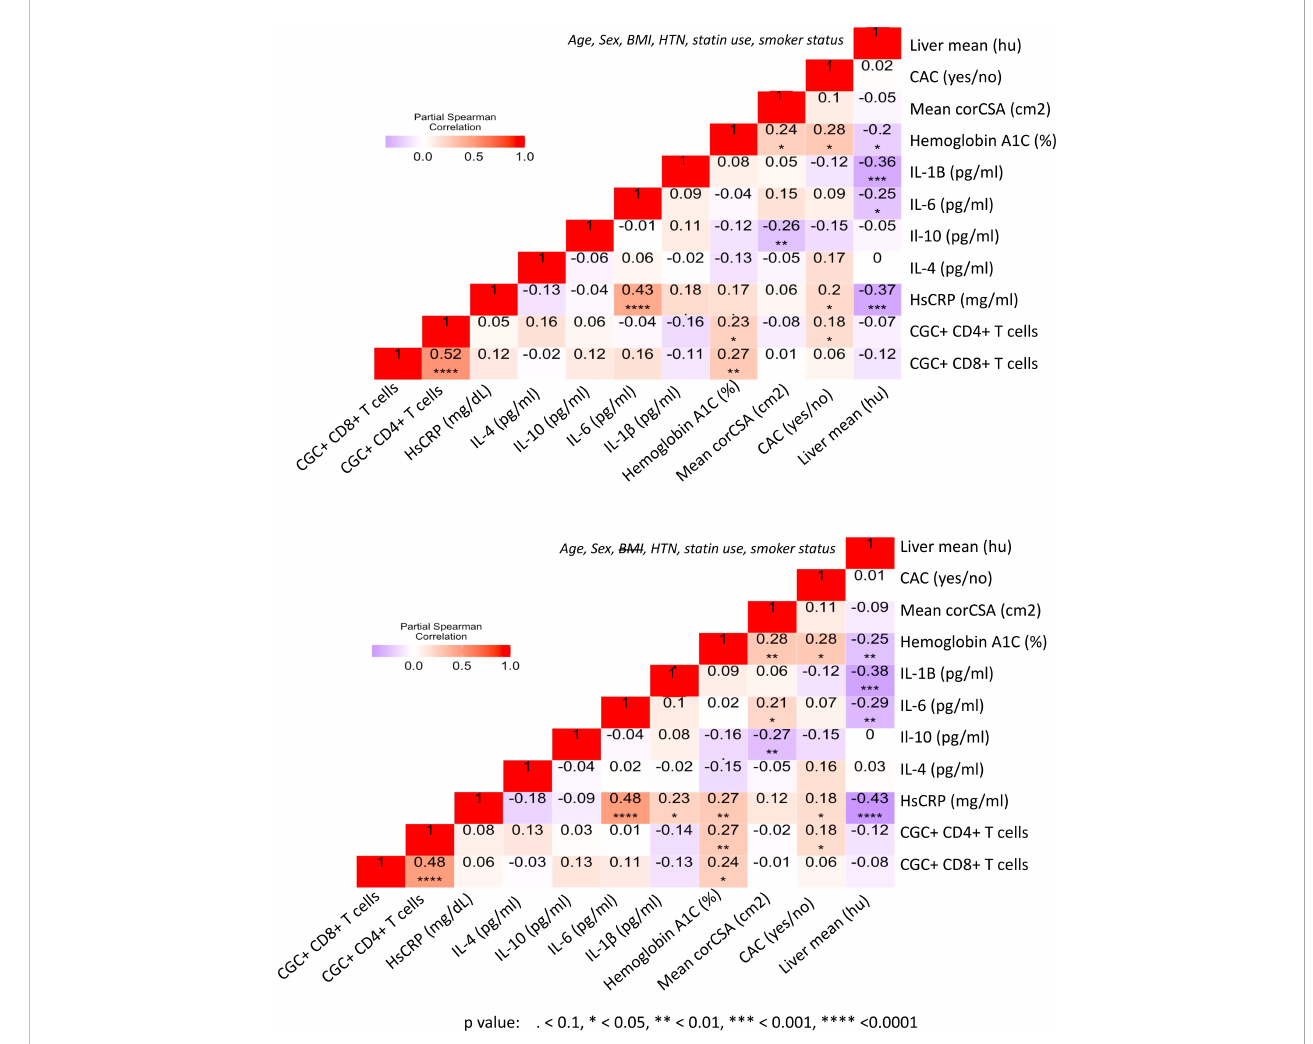
FIGURE 9 CGC + T cells are associated with higher hemoglobin A1C levels in adjusted analyses. Partial Spearman ’ s rank correlation analysis adjusted for age, sex, HTN, BMI, statin use, and smoking status (top), and after removal of BMI from the model